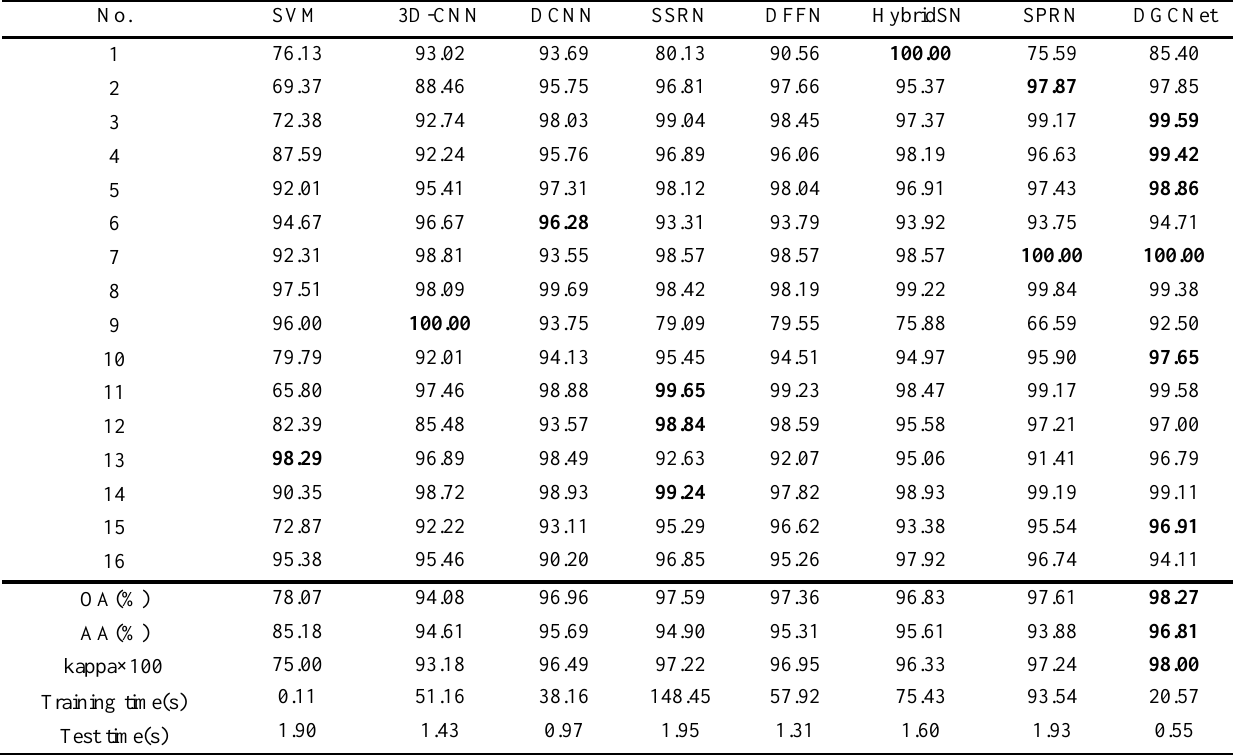
Table 3. Classification maps results obtained from our proposed DGCNet and seven comparison methods on the Indian Pines dataset., including per-class accuracy, OA, AA, kappa, training time and inference